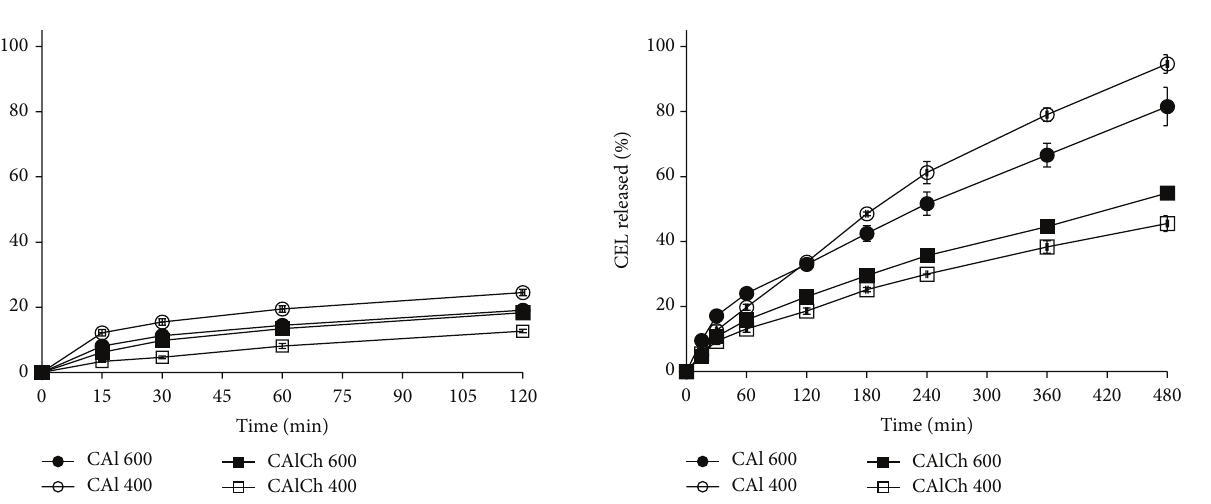
the swelling behavior of CAl 400 versus CAl 600 and CAlCh 400 versus CAlCh 600 beads (same composition, different